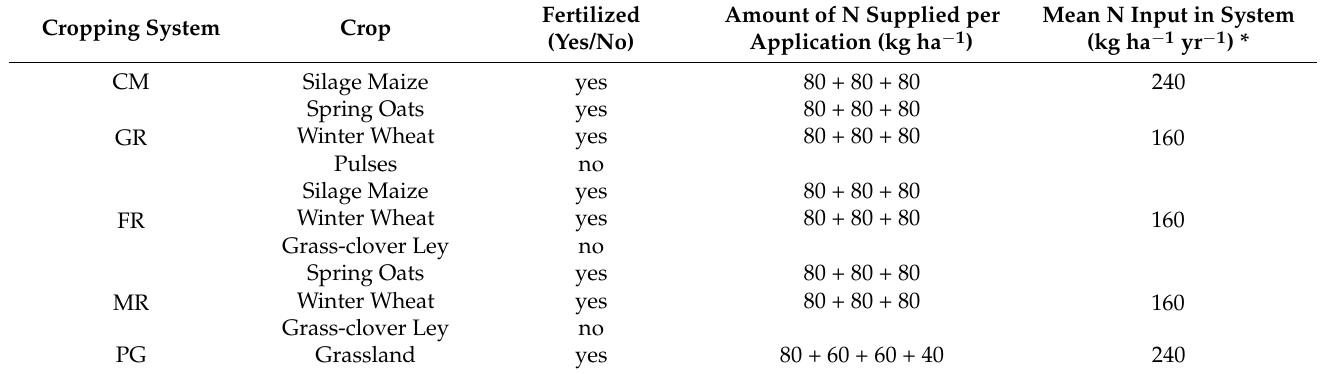
Table 2. N application plan and the average amount of N applied from cattle slurry for the N1 treatment, to each main crop and cropping system, respectively. CM: continuous silage maize, GR: grain rotation, FR: forage rotation, MR: mixed rotation, PG: permanent grassland.